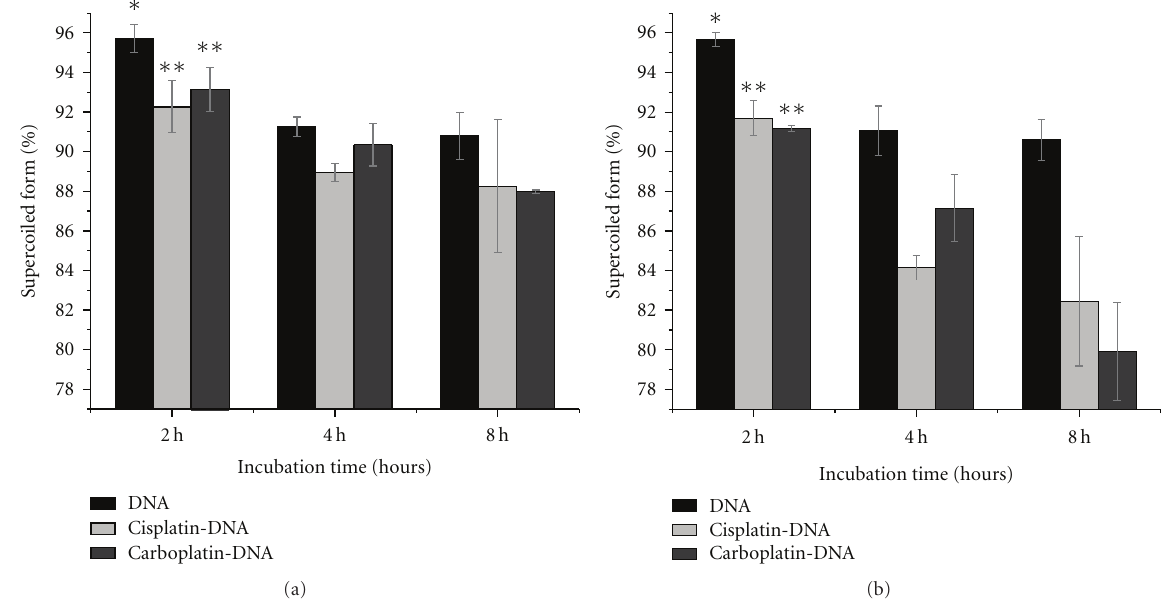
Figure 4: Comparison of the percentages of supercoiled forms in the samples of DNA, cisplatin-DNA, and carboplatin-DNA (a) in solution, and (b) on Ta substrate, after incubation for 2, 4, and 8 hours at 25 ◦ C. Data are means from three measurements; error bars show standard deviations. ∗ indicates P value > 0.05, ∗∗ indicates P value < 0.05.